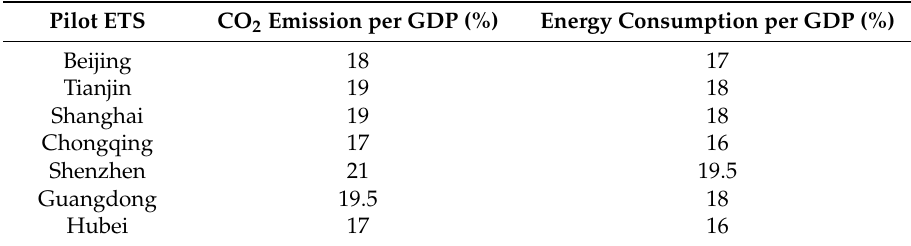
Table 3. Reduction target of China’s pilot ETS. Pilot ETS CO 2 Emission per GDP (%) Energy Consumption per GDP